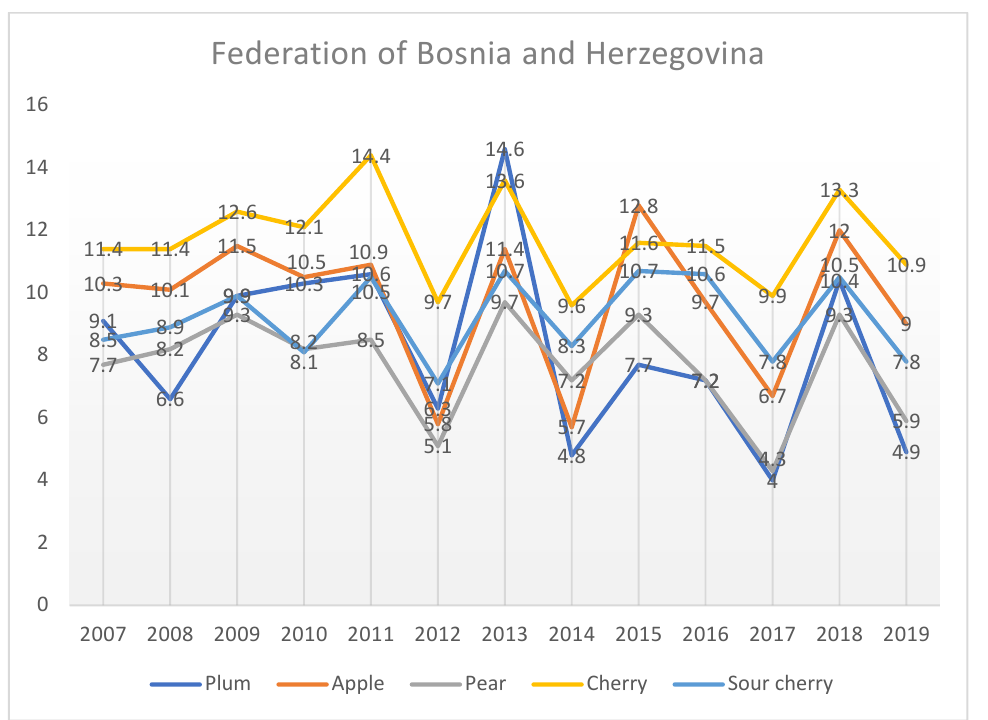
Figure 6. Fruit yield (in kg per tree) for certain fruit varieties in the Federation B&H, period 2007–2019. (Data source: Federal Institute of Statistics of FBiH, http://fzs.ba/, accessed on 15 October 2021)